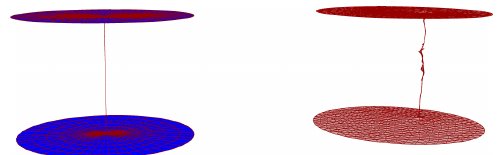
Figure 18: Conoid solution for h = 1.34 r . BATS on the left, Kangaroo on the